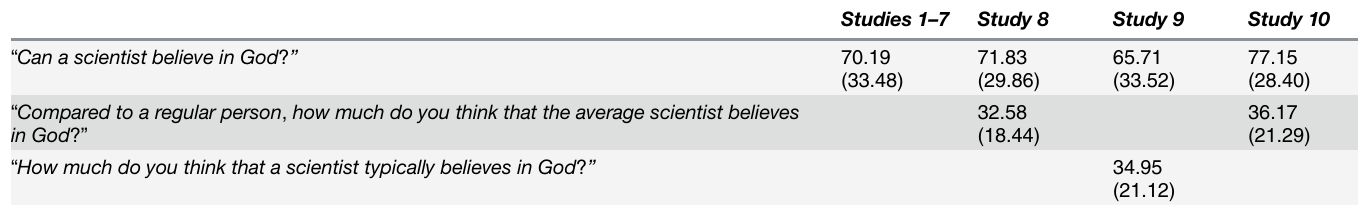
Table 2. Responses to scientists and religious belief items, and occupation of respondents, across studies. SD ’ s in parentheses. All items scored on scales ranging from 0 ( not at all) to 100 ( very much so